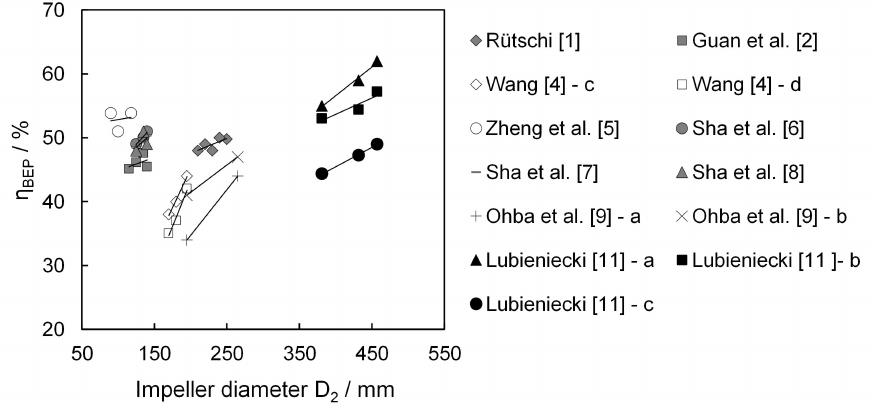
Figure 11. Efficiency over impeller